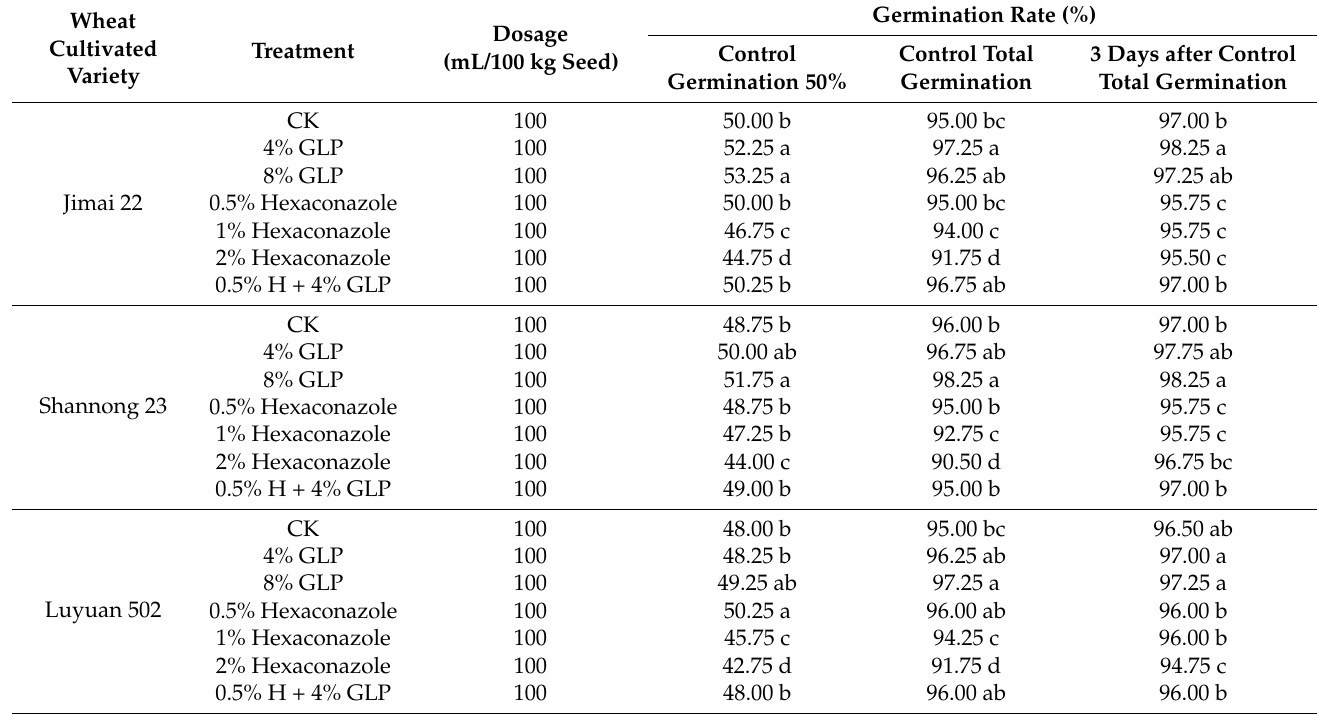
Table 5. Effects of seed dressing on wheat germination.